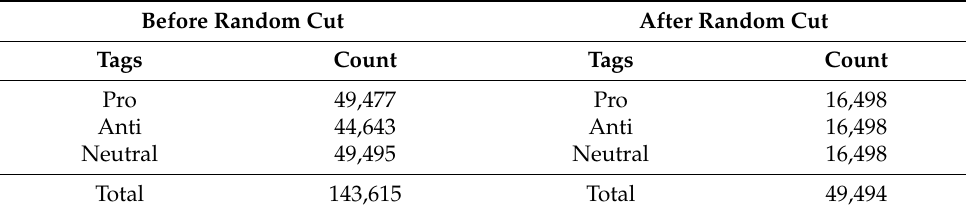
Table 3. Training and testing corpus tweet counts before and after random